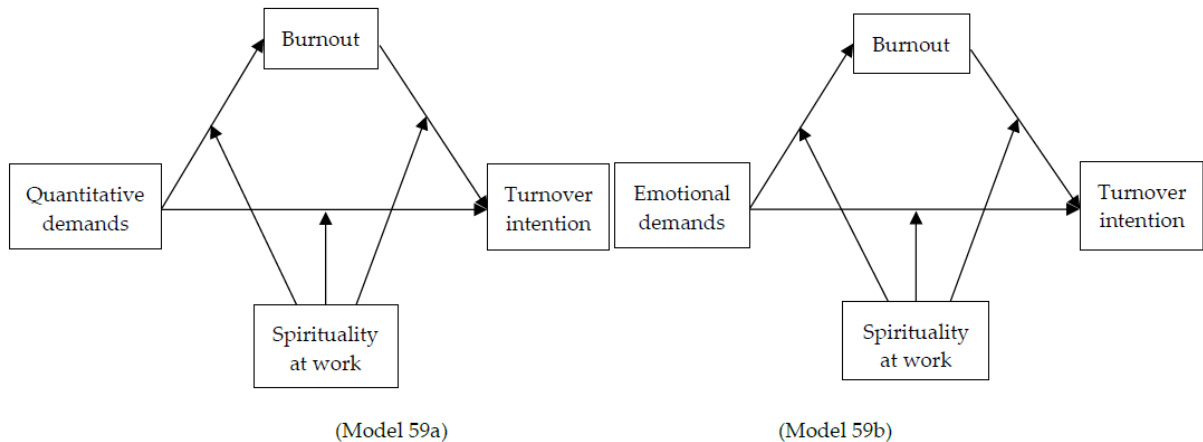
Figure 1. Conceptual models of spirituality at work as a moderator of the direct and indirect relationships between job demands and turnover intention. Model 59a: Spirituality at work as a moderator of the mediated relationship between quantitative demands and turnover intention. Model 59b: Spirituality at work as a moderator of the mediated relationship between emotional demands and turnover intention. Both models were controlled for gender and job seniority.